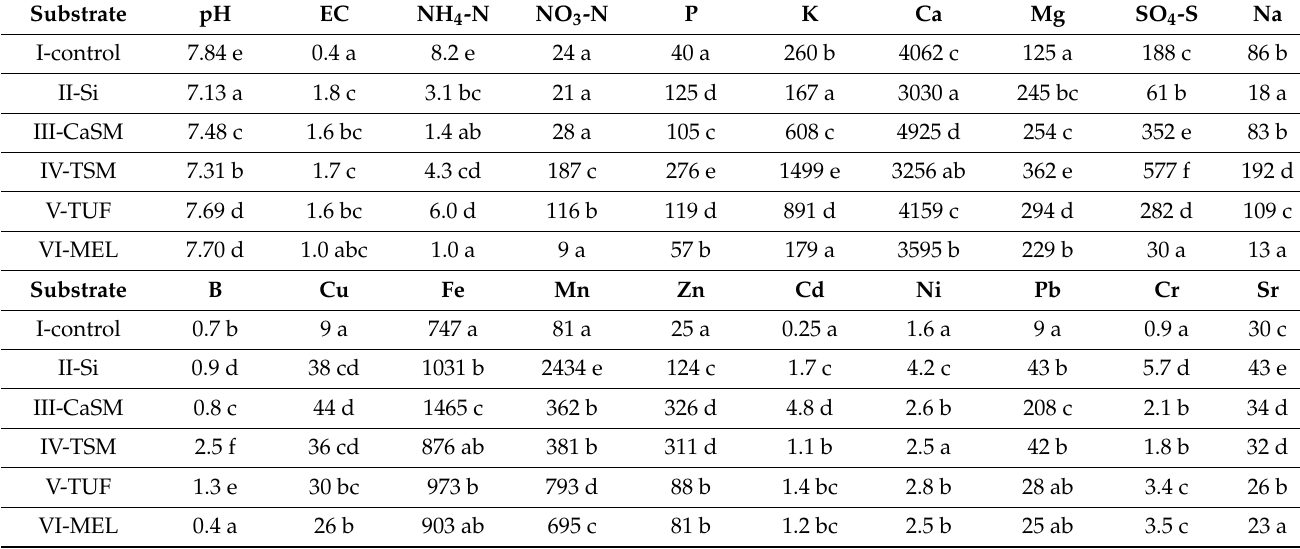
Table 5. Soil reaction (pH H2O ), salts concentration (EC—mS cm − 1 ), macronutrients (mg dm − 3 ), and trace elements (mg kg − 1 ) contents in substrates estimated before